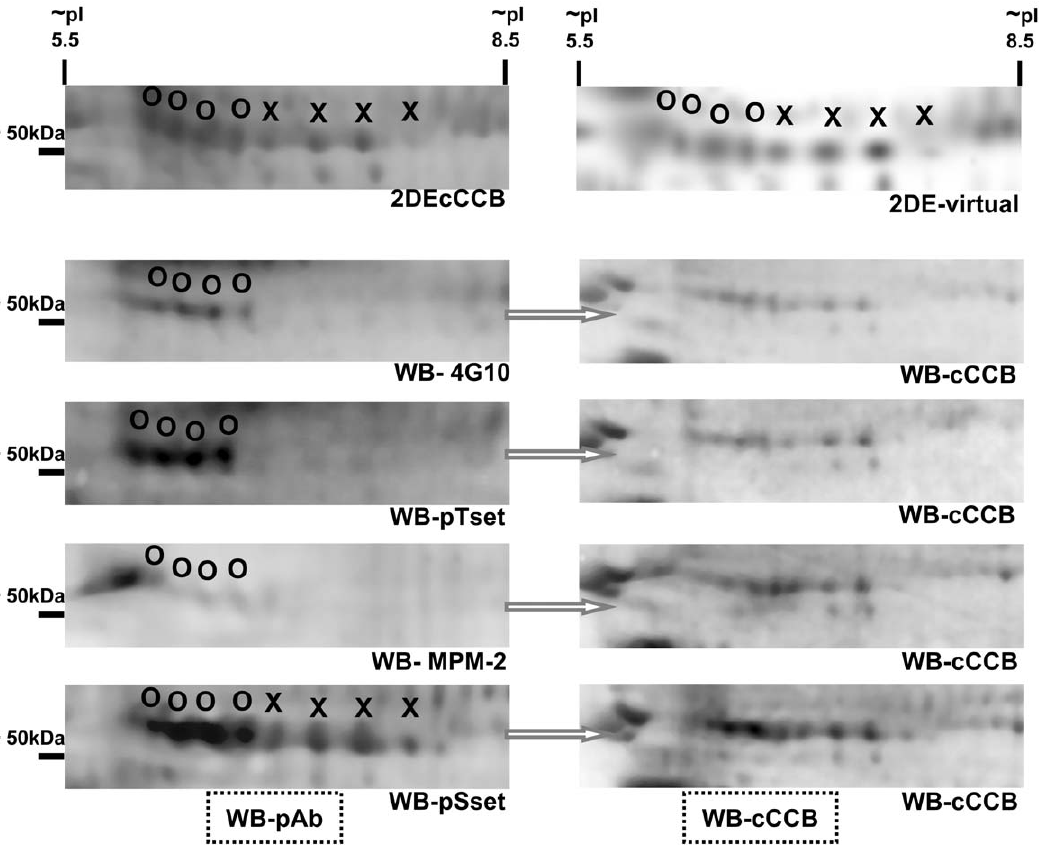
Figure 6. Specificity of the anti-phosphoproteins antibodies. The phosphoserine specific antibodies pSset recognized aldehyde dehydrogenase (P47738) and selenium-binding protein 1 (P17563), whereas the MPM-2, sYset and 4G10 identified the former only. O=spots identified as selenium-binding protein 1 (P17563); X=spots identified as aldehyde dehydrogenase (P47738). On the right side are depicted the same membrane after cCCB post staining.